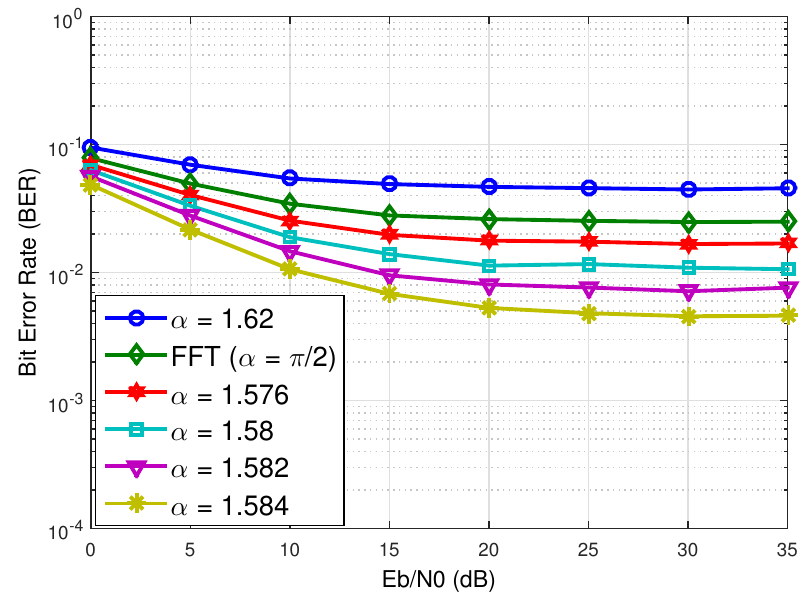
Figure 6. BER for 2-ASK FrFT-based OFDM over the frequency-selective UWA channel with CFO = 0.15 for different values of α